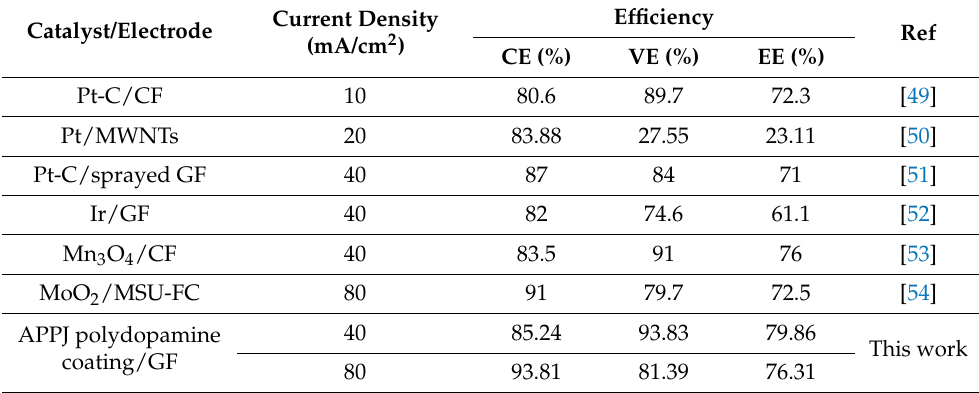
Table 2. Comparison of APPJ-coated polydopamine on GF as electrode materials with the litera- ture.